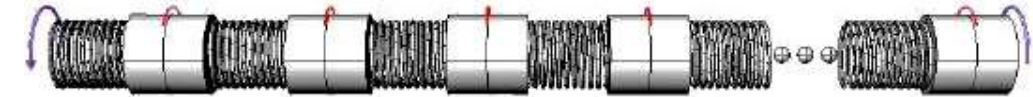
Table 7. Hull characteristics.